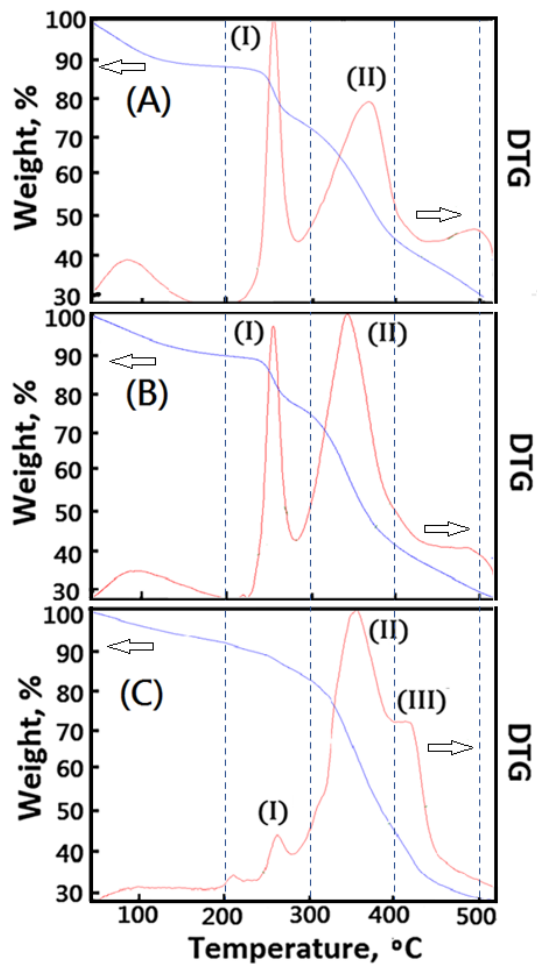
Figure 7. Figure 7. Thermogravimetric analysis of the composite foam materials without CaCl 2(aq) : ( A ) ( A ) PCFM1N, ( B ) PCFM2N, and ( C ) PCFM1N, ( B ) PCFM2N, and ( C ) PCFM3N.